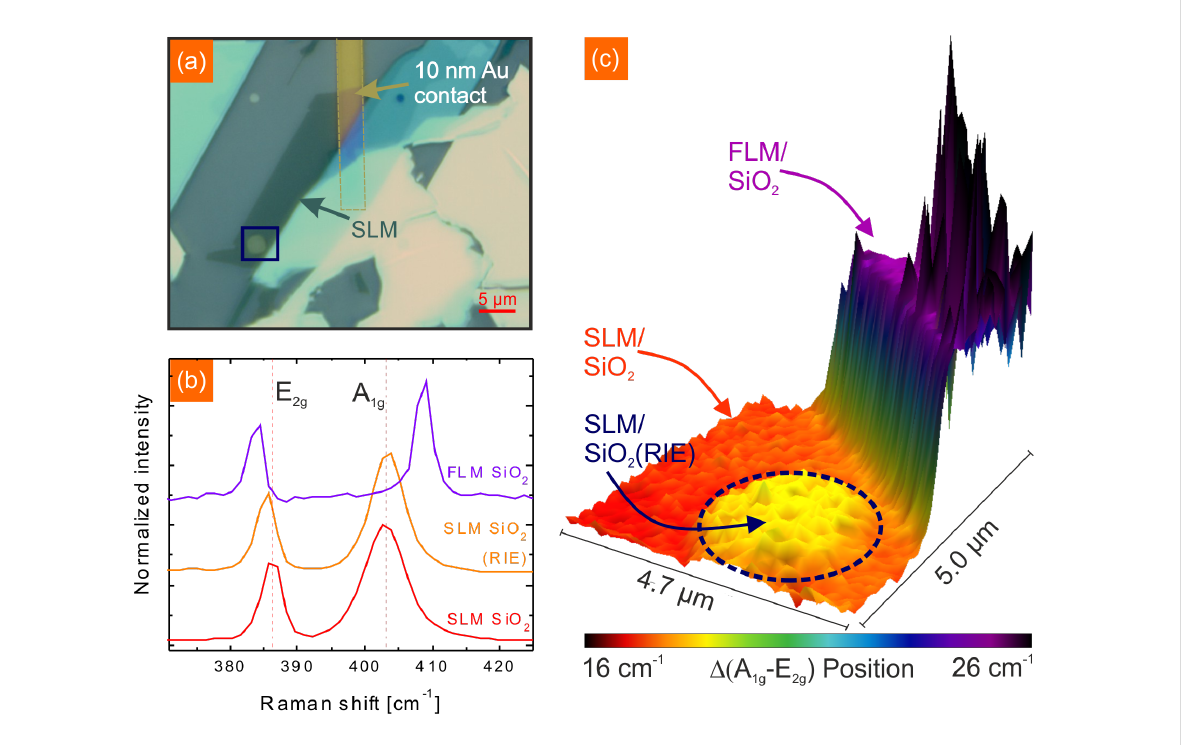
Figure 2: (a) Optical microscope image of an exfoliated MoS 2 flake on a prepatterned (RIE) SiO 2 substrate. A gold contact was attached to the MoS 2 in order to ground the flake for KPFM measurements. (b) Raman spectroscopy spectra of SL and FL MoS 2 on SiO 2 and SL MoS 2 on RIE SiO 2 . For higher layer numbers the E 2 g is shifted to lower wave number while the A 1 g mode is shifted to higher wave numbers. (c) Raman mapping data of the area marked in (a) with the blue box. The difference between A 1 g and E 2 g mode is plotted revealing a shift of the Raman modes for SLM on the RIE SiO 2